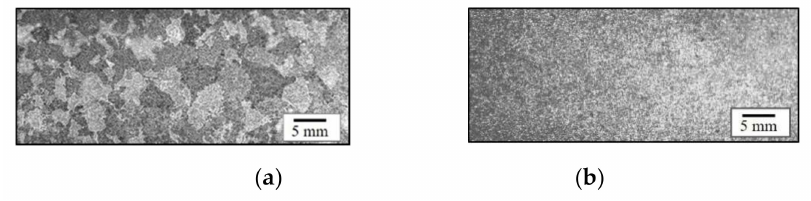
Figure 8. Macrostructure of hypereutectic alloy 5: ( a ) untreated; ( b ) complex flux.